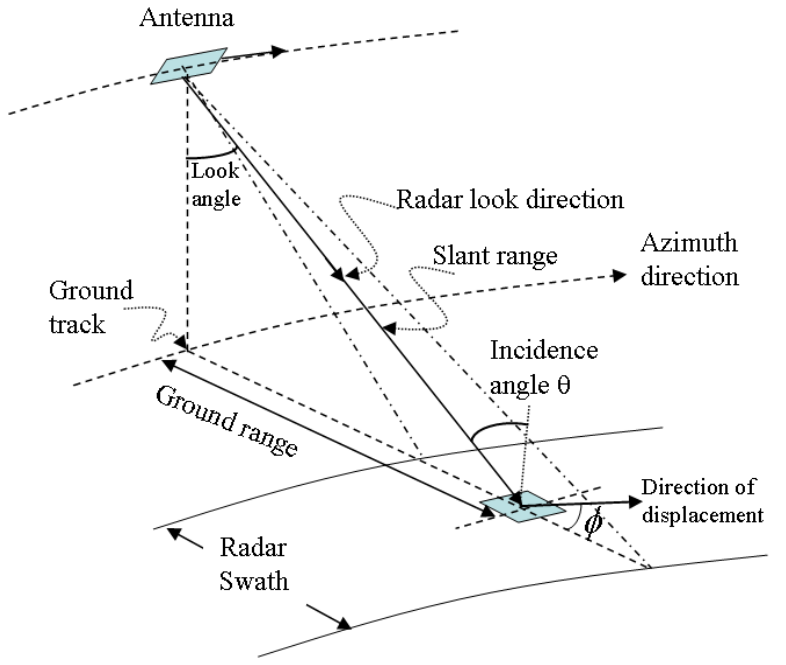
Figure 1. A geometric model for a SAR system. Slant range is the length between the antenna and ground pixel and ground range is the distance between the ground track and the ground